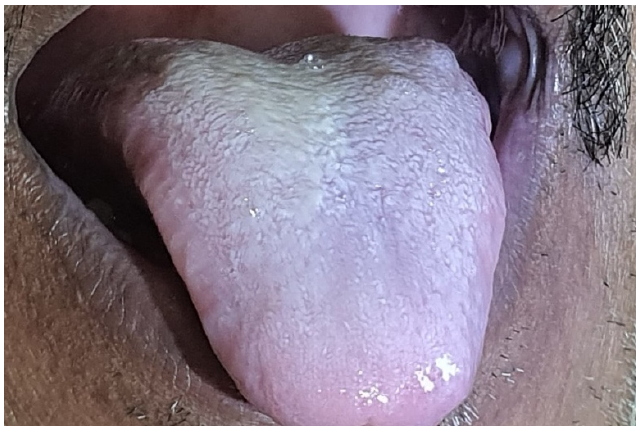
Figure 2. This is a clinical picture showing a discoloured tongue of a patient with confirmed mu- cormycosis. Table 1. Clinical characteristics of patients with confirmed